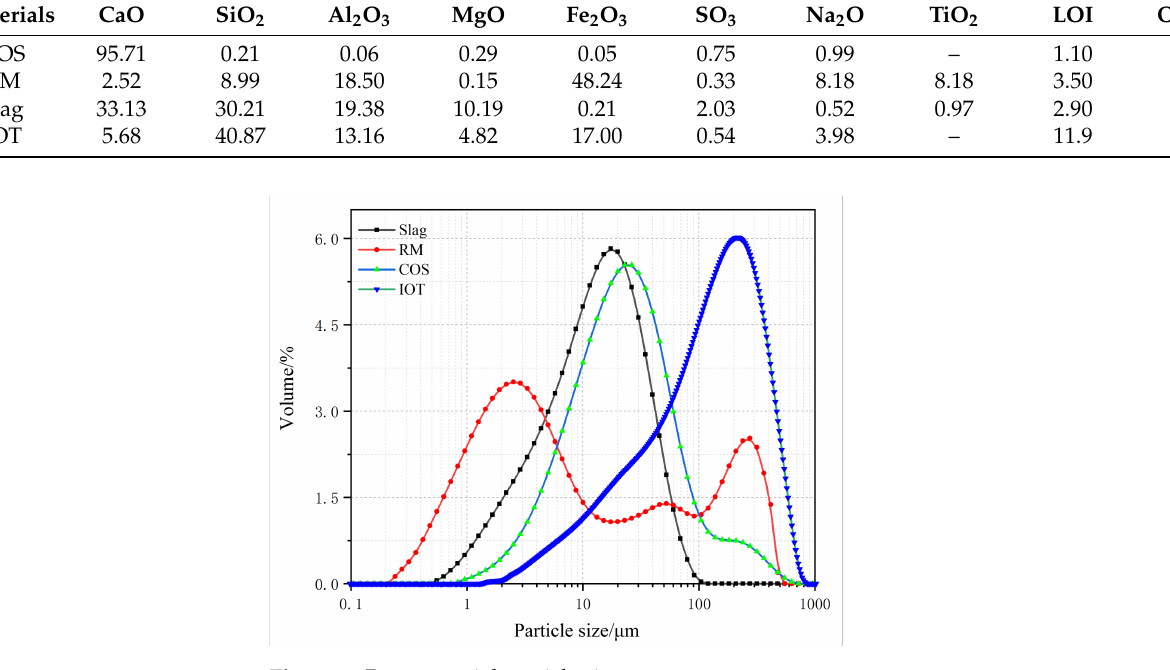
Figure 1. Raw material particle size